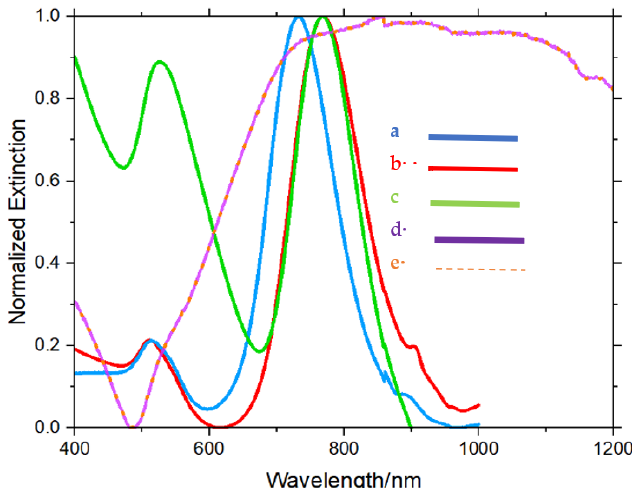
Figure 2. Experimental spectra: extinction spectra of the aqueous colloidal dispersions: AuNR ( a , blue line); AuNR@SiO 2 ( b , red line); AuNR@SiO 2 @seed ( c , green line); AuNR@SiO 2 @Au ( d , violet line) overlapping with AuNR@SiO 2 @Au@SiO 2 ( e , orange dotted line).